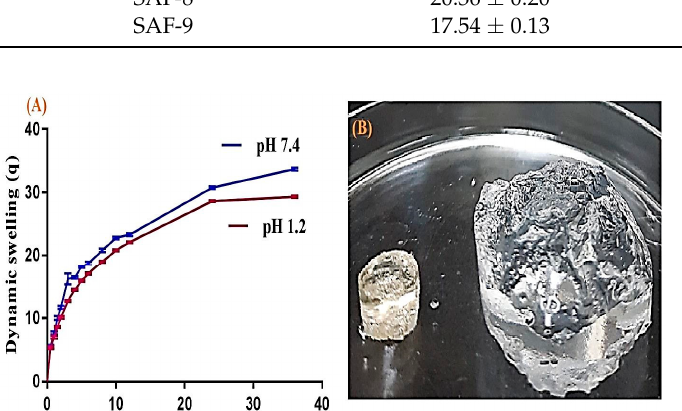
Figure 6. XRD of (A) DS, (B) unloaded SA ‐ co ‐ poly(AMPS) hydrogel, (C) loaded SA ‐ co ‐ poly(AMPS) hydrogel